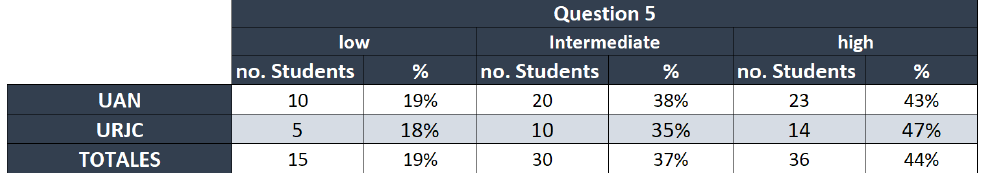
Figure 11. Distribution of responses to Question 5 according to the three grades of reflection (low, intermediate, high) by giving the number of students (no.students) classified and their percentage (%) of the total in their row (UAN, URJC and